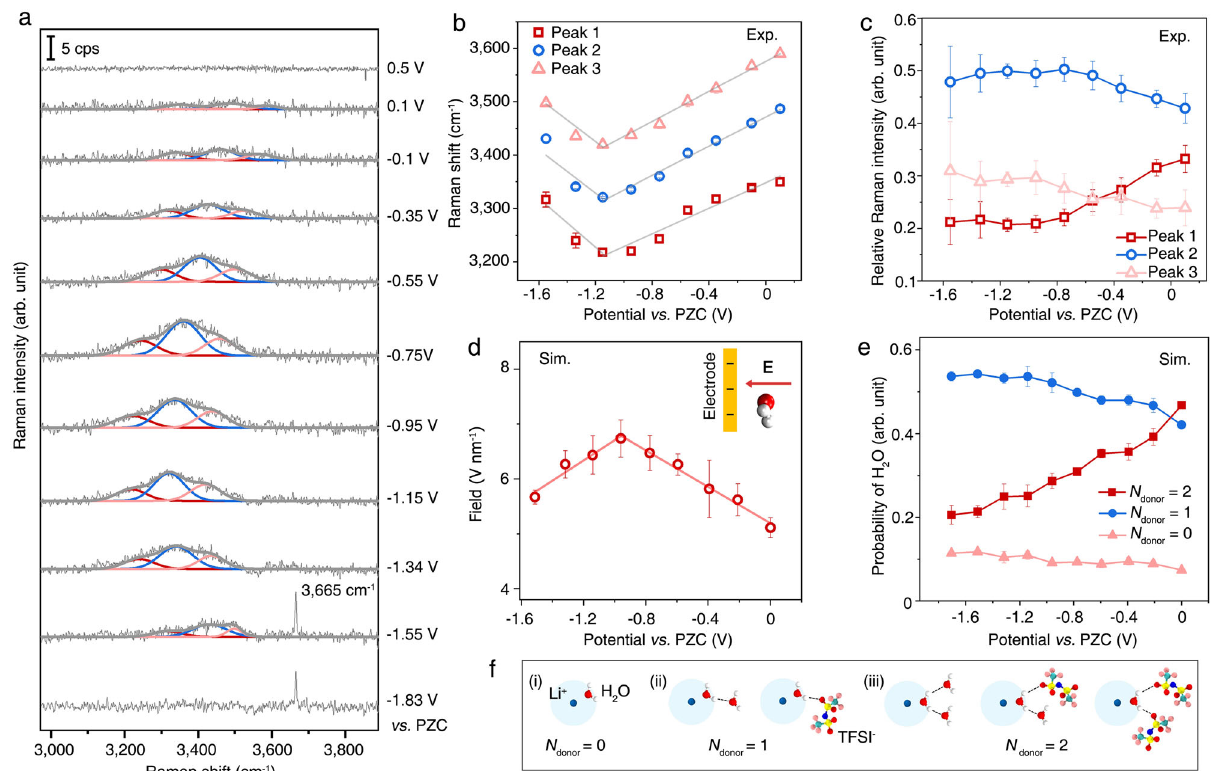
Fig.2|VibrationalRamanspectraofinterfacialwateratAu(111)|WiSelectrolyte (21m LiTFSI) interface. a In situ electrochemical Raman spectra of the OH stretching modeofinterfacial water atthe Au(111) surface measured in 21m LiTFSI aqueous electrolyte (gray curves) and their fi ts to the sum ofthree Gaussian bands of increasing frequency: Peak 1 (red), 2 (blue), and 3 (pink). b Potential-dependent frequencies of Peak 1 (red squares), 2 (blue circles), and 3 (pink triangles) of interfacialwaterobtainedfromspectral fi tsinpanel a andtheirlinear fi t(solidlines) inregionsof+0.1~ − 1.15Vand − 1.15~ − 1.55V. c ,Potentialdependenceoftherelative intensities of Peak 1 (red squares), 2 (blue circles), and 3 (pink triangles) obtained fromthe fi tsin a .Herein,arelativeRamanintensitypro fi lerepresentingthechange in the portion of total intensity was used to avoid the variation of plasmonic enhancementduringthepotentialscan. d ,Simulatedelectric fi eld( E )strength(red circles) experienced by the interfacial water and the linear fi t (solid red line) in